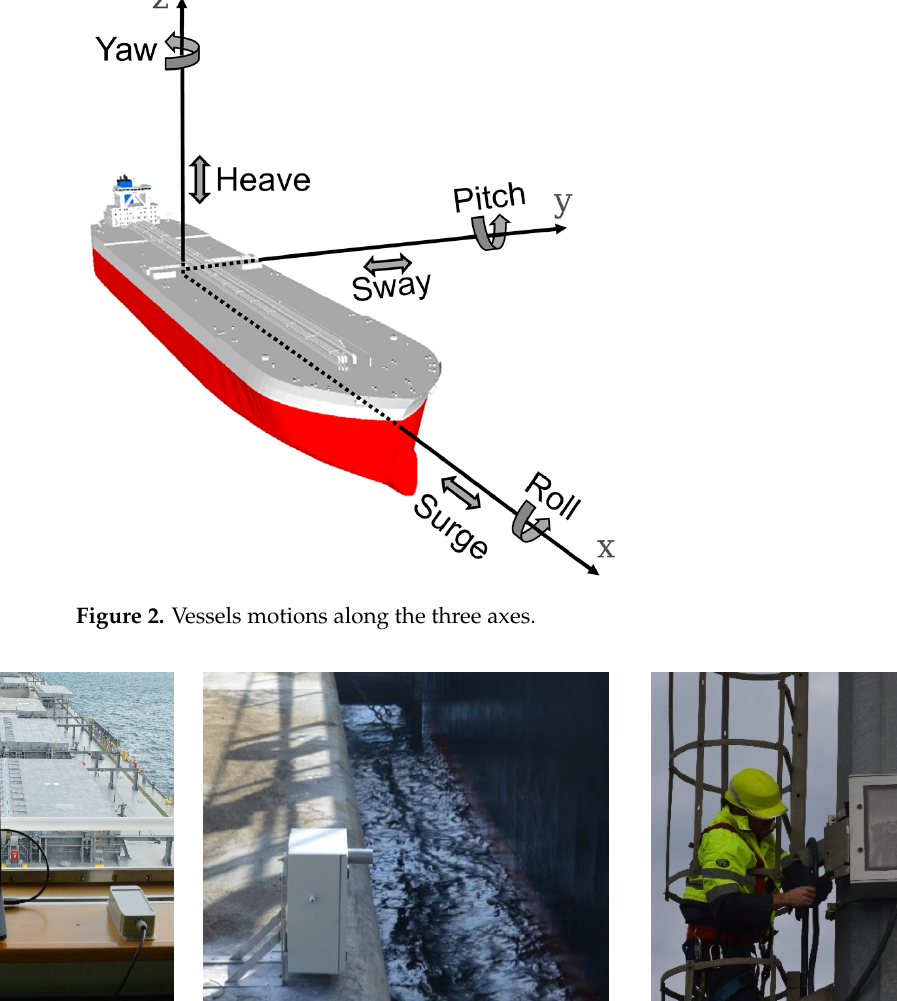
Figure 2. Vessels motions along the three axes.